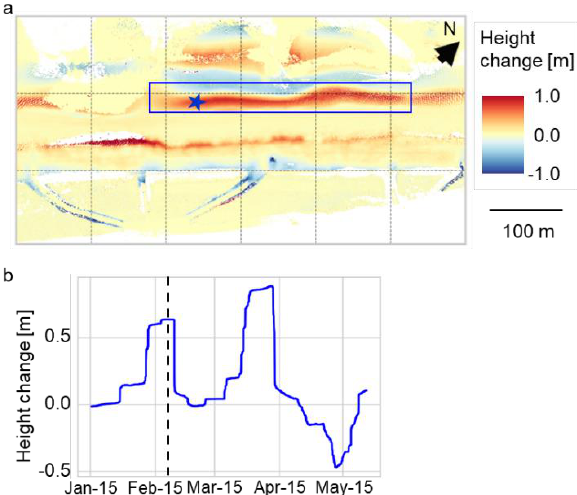
Figure 2. (a) Surface height change on the beach in a five-week period with a sand bar as notable accumulation form (blue rectangle marks bounding box). (b) History of height change at a location within the spatial extent of the sand bar (location marked by star in a). The dashed line in b designates the epoch of 2017-02-20 corresponding to the surface change map in a.